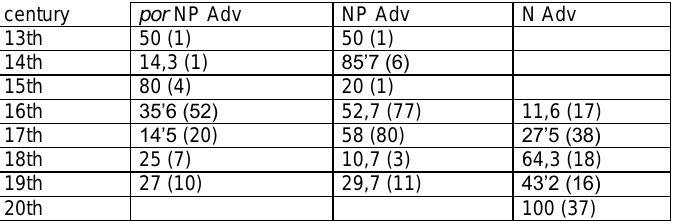
Table 5. Frequency of río abajo/ayuso ‘downriver’